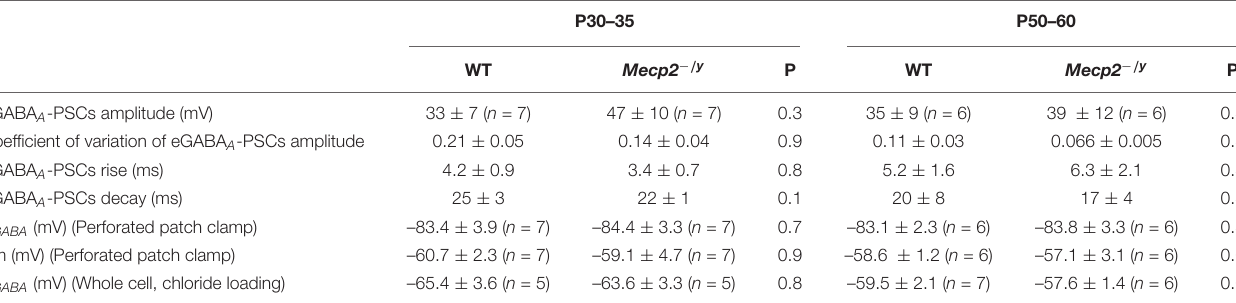
TABLE 1 | Reversal potential of evoked GABA A -receptor-mediated synaptic current on WT and Mecp2-null CA3 hippocampal pyramidal neurons (two-tailed Mann–Whitney U